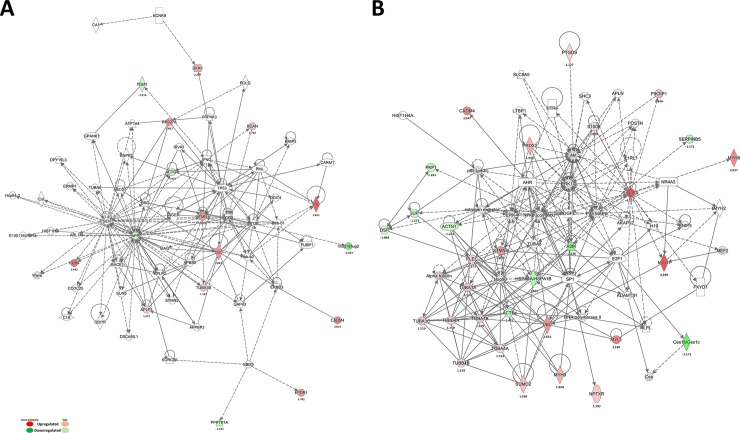
Protein-protein interaction network analysis of differentially expressed proteins.Network analysis was performed using ingenuity pathway tools (www.ingenuity.com) on proteins annotated in the Ingenuity database. (A) Neurological disease-related network and (B) inflammatory response-related network; the red nodes represent up-regulated proteins, and the green nodes represent down-regulated proteins.